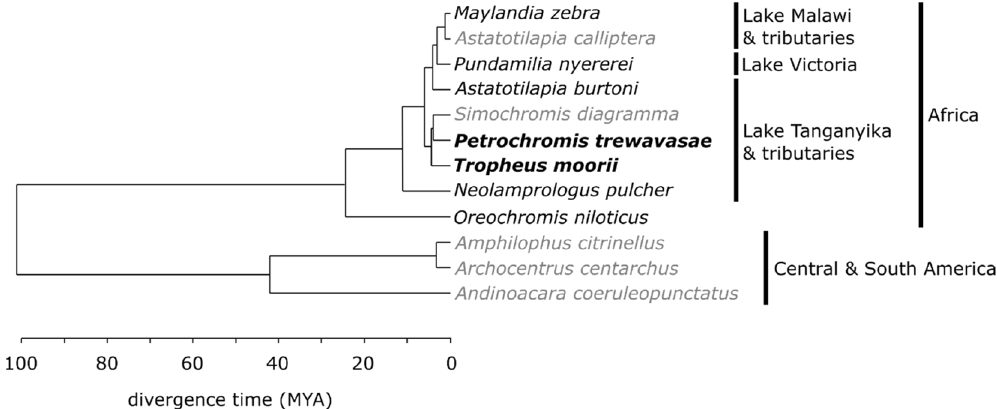
Figure 1. Time calibrated phylogeny of cichlid species with publicly available complete genomes. The phylogeny is based on 519 anchored genome loci either sequenced or extracted from the genome sequence 6 . The study species are highlighted in bold, species with annotated high quality genomes are in black and species with high quality assemblies (but not yet annotated genomes) are indicated in grey (Figure created with Inkscape https ://inksc ape.org).